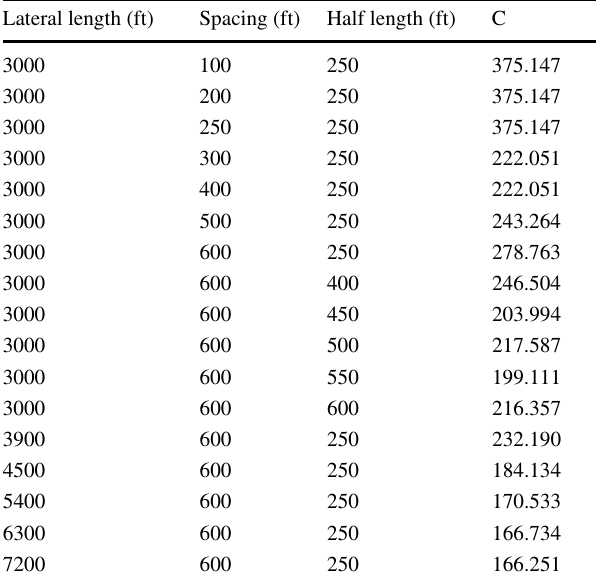
Table 14 DV from fracture-spacing sensitivity